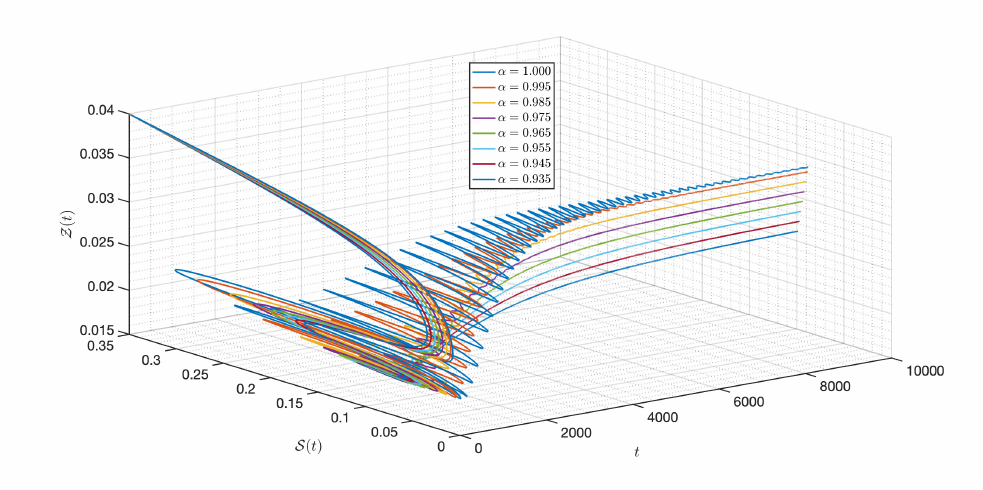
Figure 21. Dynamic of the model (3) for different parameters in Case II .